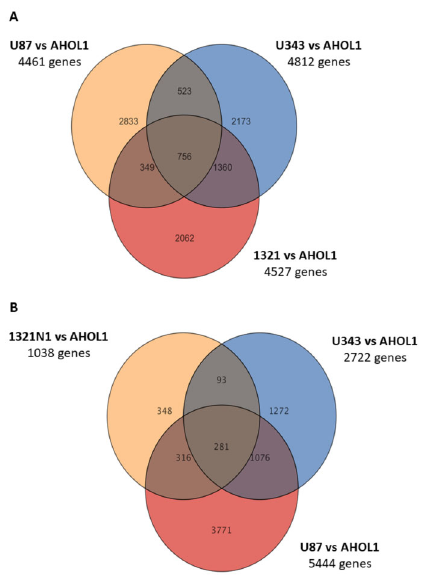
Figure 5. Venn diagram showing the number of genes upregulated ( A ) and downregulated ( B ) in all glioblastoma cell